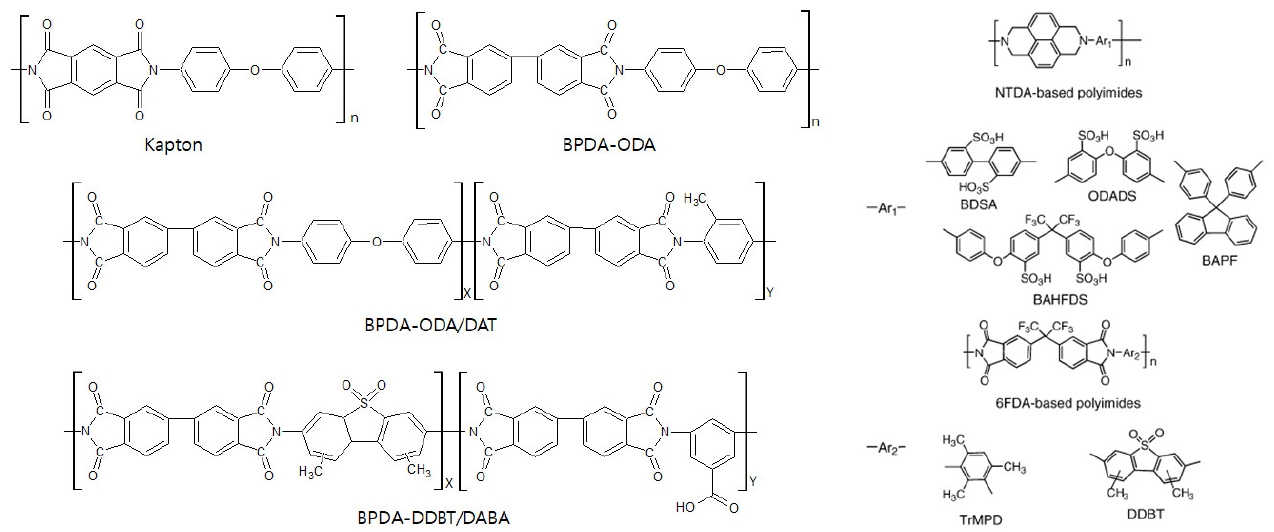
Figure 11. Kapton, and BPDA- and NTDA-based polyimide precursors. Adapted from [39] with permission. Copyright (2005) Elsevier.